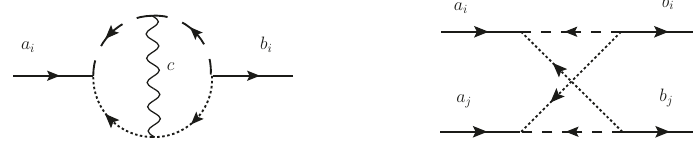
Figure 7 . The diagrams arising from the building block C 0 C 0 respectively. Only the box diagram on the right contributes to the leading order in the a i ;a j ;b i ;b j double scaling